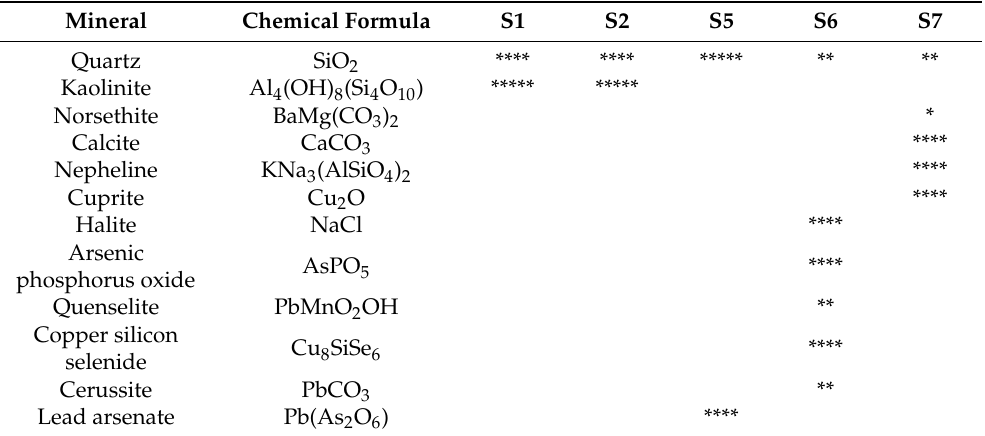
Figure 3. PMT content (mg·kg − 1 ) and pH distribution in sampling sites inside a decommissioned REE plant. Table 5. XRD-based mineralogy of soils sampled at different sites inside the decommissioned REE